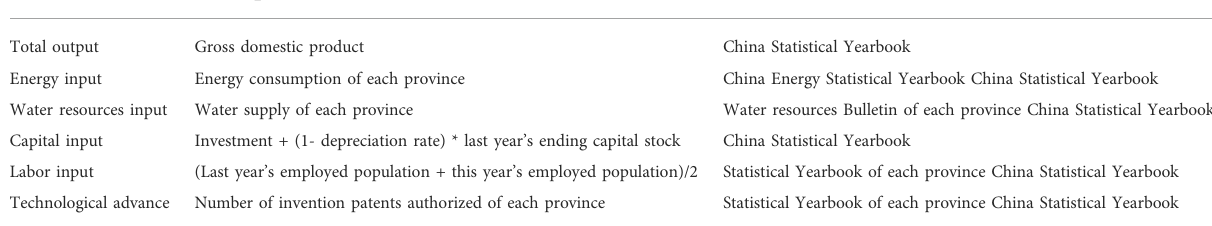
TABLE 2 Variable